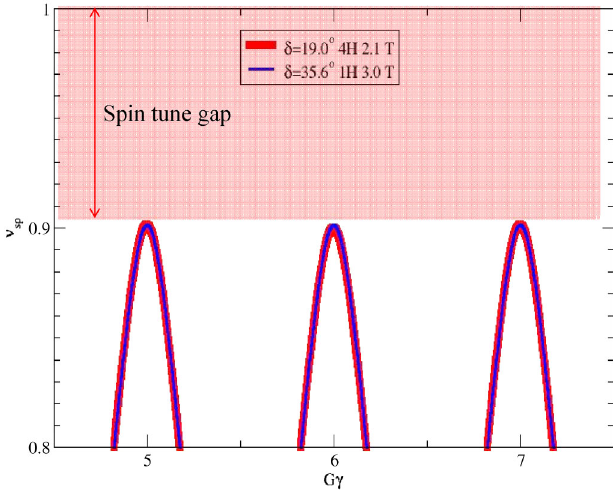
FIG. 5. The fractional part of the spin tune generated by four helices (thick red curve) and by a single helix (thinner blue curve). Note that the single helix requires a strength of 3 T to generate the same spin tune as that of four helices which require a field of 1.9 T each.